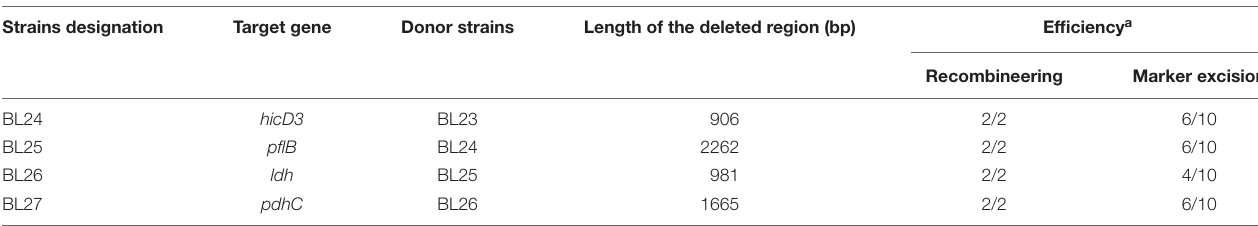
TABLE 3 | Experimental details for the single-plasmid system.